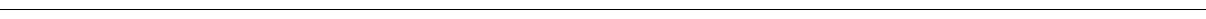
Fig. 1 Structure of Mtb PYK and overview of three allosteric sites of PYK. a Crystal structure of the Mtb PYK-OX/AMP/G6P complex (PDB ID 5WSB) in the synergistically activated R-state. Two orthogonal views of Mtb PYK-OX/AMP/G6P show the tetramer architecture, domain boundaries, active site and synergistic effector sites. The A – A (large) and C – C (small) interfaces between subunits are shown as dashed lines. Each subunit comprises three domains, and one subunit (chain A) is coloured to show the domains: A-domain in green (residues 1 – 70, 168 – 336), B-domain in yellow (residues 71 – 167), C-domain in cyan (residues 337 – 472). The N terminus and C terminus of this subunit are indicated. Polypeptide chains are shown as cartoons, while metals and ligands are represented by spheres. Mg 2+ and K + located at the active site (brown box) are coloured in green and purple, respectively. The oxalate molecule (OX) at the active site is associated with the Mg 2+ . The canonical allosteric site (AMP-bound) is indicated by the purple box, while the newly discovered G6P-binding site (synergistically coordinating with the AMP-binding site) is shown by the magenta box. The AMP-binding loop (AMP loop) and G6P-binding loop (G6P loop) are coloured black. The C-terminal loop (tail loop) which undergoes a conformational change in the transition of inactive- and active states is indicated. b A surface representation of the PYK monomer (A-, B- and C-domains) highlighting three allosteric effector sites: canonical allosteric site that binds AMP, F26BP or F16BP; amino-acid site found in mammalian M1/M2PYK that binds amino acids as a nutrient sensor; sugar monophosphate site that binds G6P in M. tuberculosis synergistically coordinating with the canonical site, and probably binds R5P or G3P in some organisms. The A-, B- and C domains are shown in green, yellow and cyan, respectively. Effector-site ligands are shown as